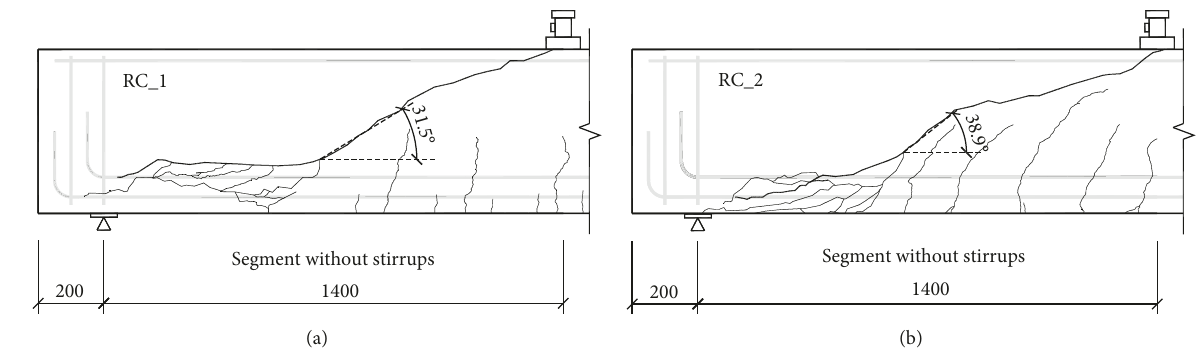
Figure 7: Depiction of cracking pattern at shear failure for RC_1 and RC_2 (units: